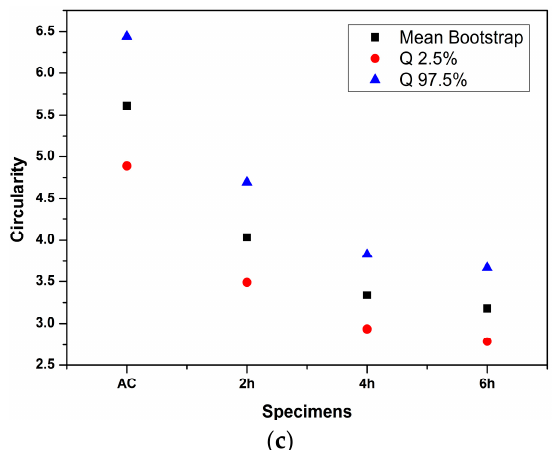
Figure 6. The values of indices for the as ‐ cast and after homogenization time 2 h, 4 h, and 6 h: ( a ) aspect ratio; ( b ) feret; ( c ) circularity.